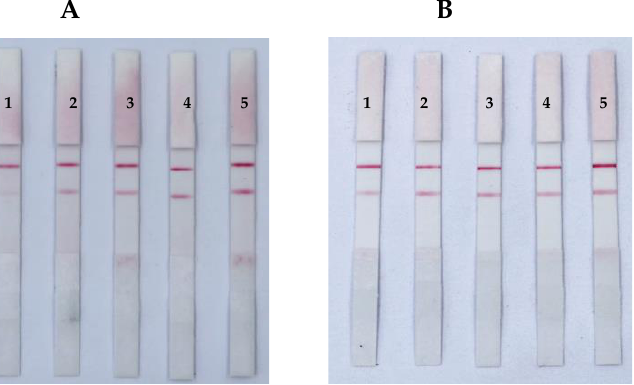
Figure 3. Optimization of antibody concentrations. ICSs of ZEN ( A ), and T-2 ( B ). Amount of anti-body (labels 1 –5) were 1.9, 2.1, 2.3, 2.5, and 2.7 μg, respectively.